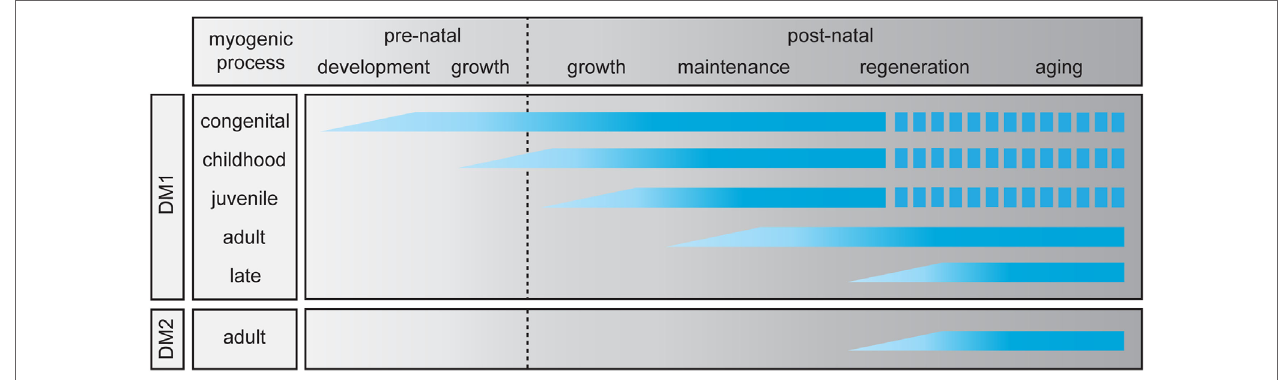
FiGURe 2 | Abnormalities in skeletal muscle myogenesis in myotonic dystrophy (DM). For myotonic dystrophy type 1 (DM1), five clinical subtypes have been identified (19), while for myotonic dystrophy type 2 (DM2) only the adult-onset manifestation is known. The myogenic process in skeletal muscle is divided in